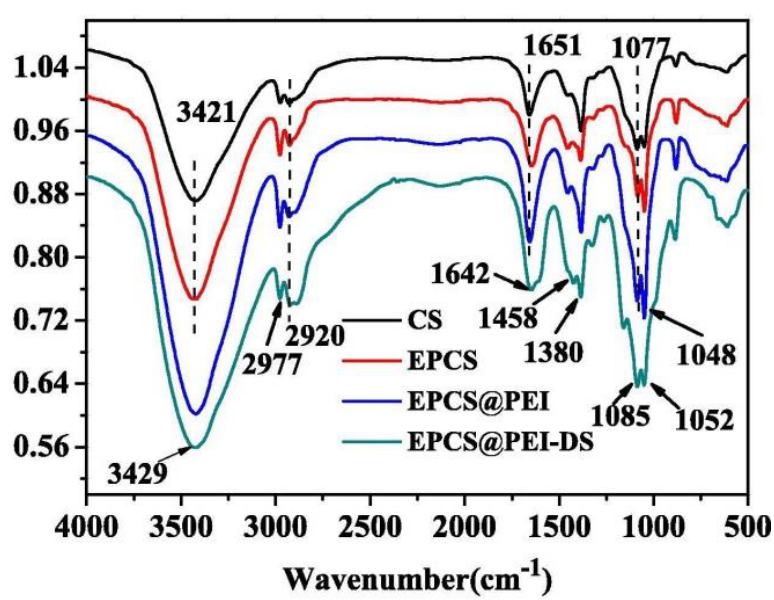
Figure 11. FTIR spectra of CS, EPCS, and EPCS@PEI before and after adsorption (in the above Figure, DS is abbreviated the DCF compound) [12].